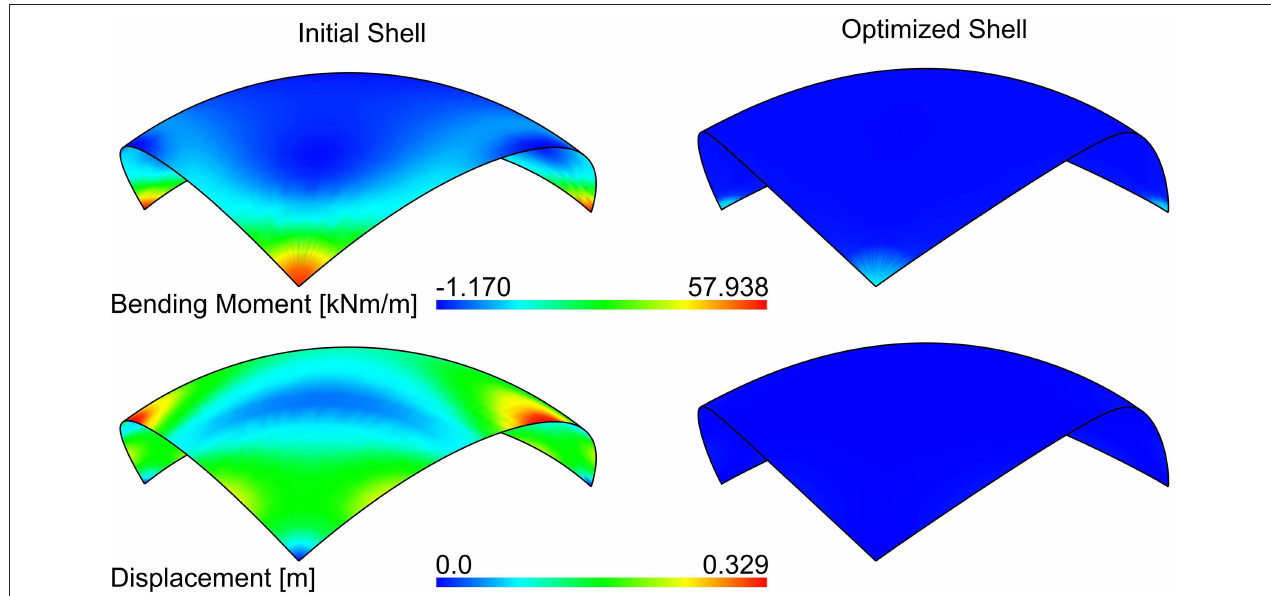
FIGURE 9 | Bending moment and displacement of the initial and optimized shell geometry for the Kresge Auditorium under a vertical load of 0.54 kN/m 2 . Deformation of the arch’s midpoint: for the initial shell 0.314 m vertically and 0.098 m toward the center; for the optimized shell 0.086 m vertically and 0.024 m toward the